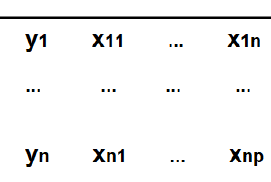
Figure 2. Logistic regression—the pattern of approximate relationship between a dependent variable (y) and an independent (x) variables